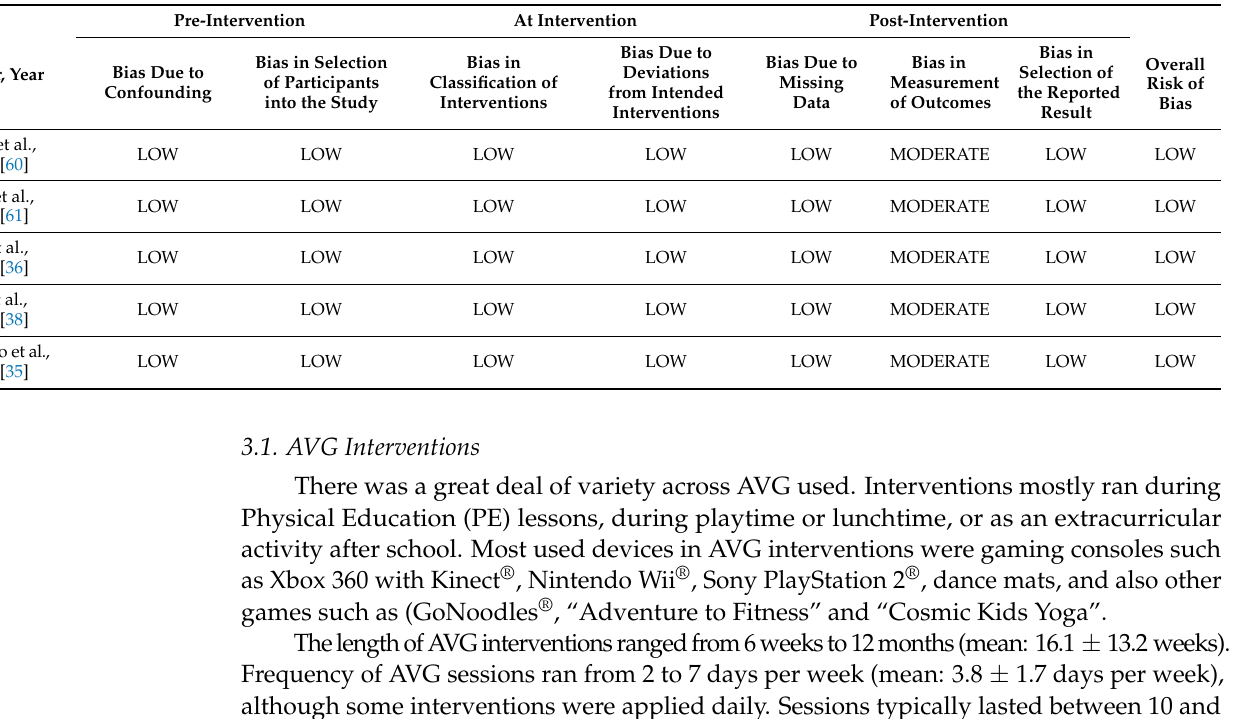
Table 2. Quality assessment of non-randomized controlled